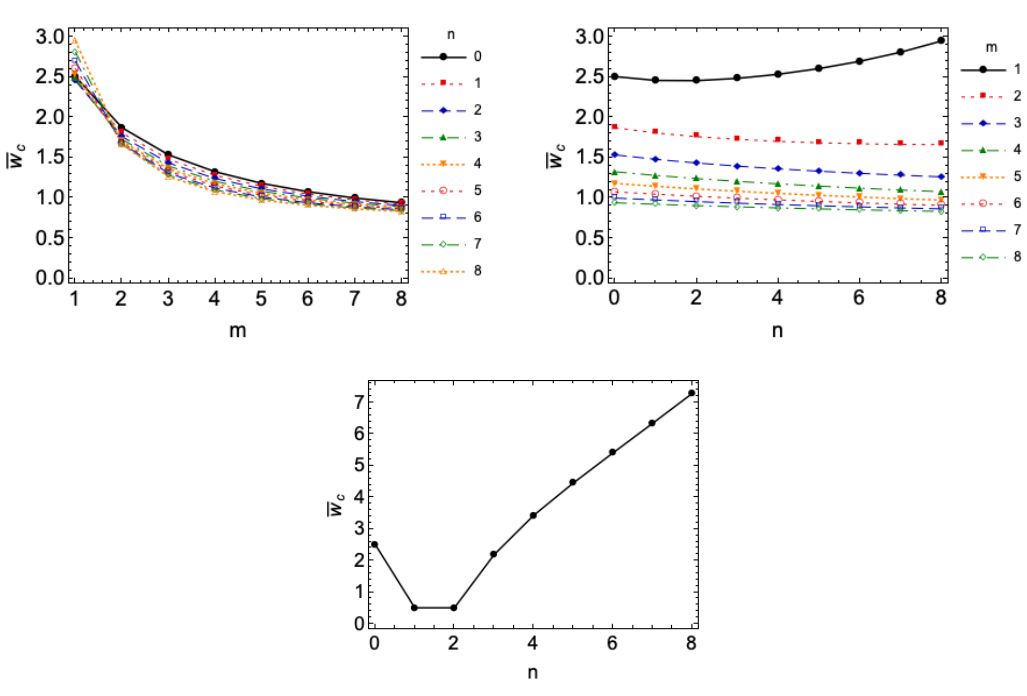
Figure 4 . The pseudo-thermalization time w c for n; m 2 f 0 ; (cid:1) (cid:1) (cid:1) ; 8 g and (cid:14) c = 10 (cid:0) 2 . Panels are the same as in (cid:12)gure